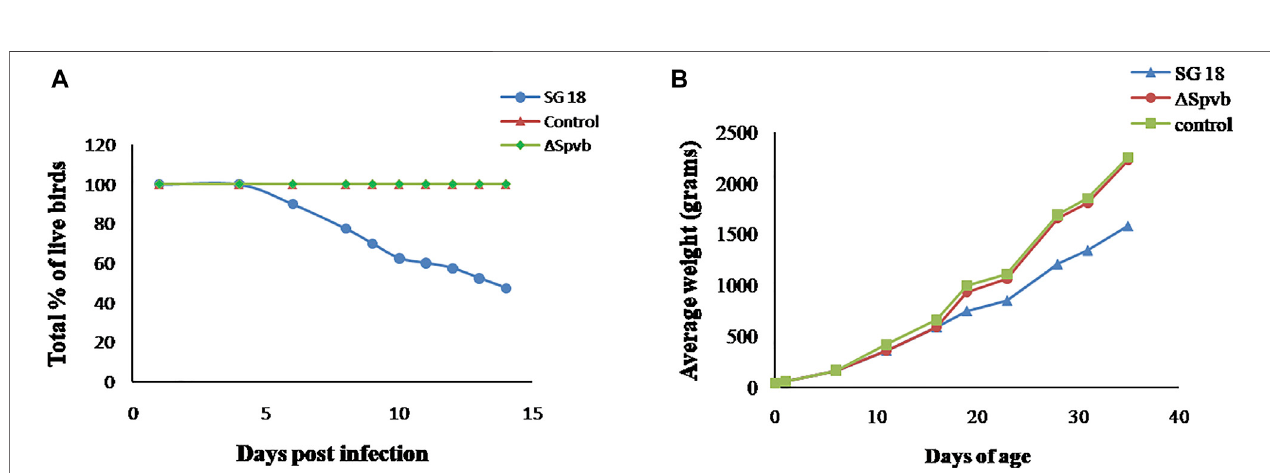
FIGURE 6 | (A) Rate of mortality in chickens observed during 15 days after infection with SG18 and Δ SpvB_SG18 strains. (B) Effect of SpvB deletion from S. gallinarum on poultry weight during the 36 days of experiment.